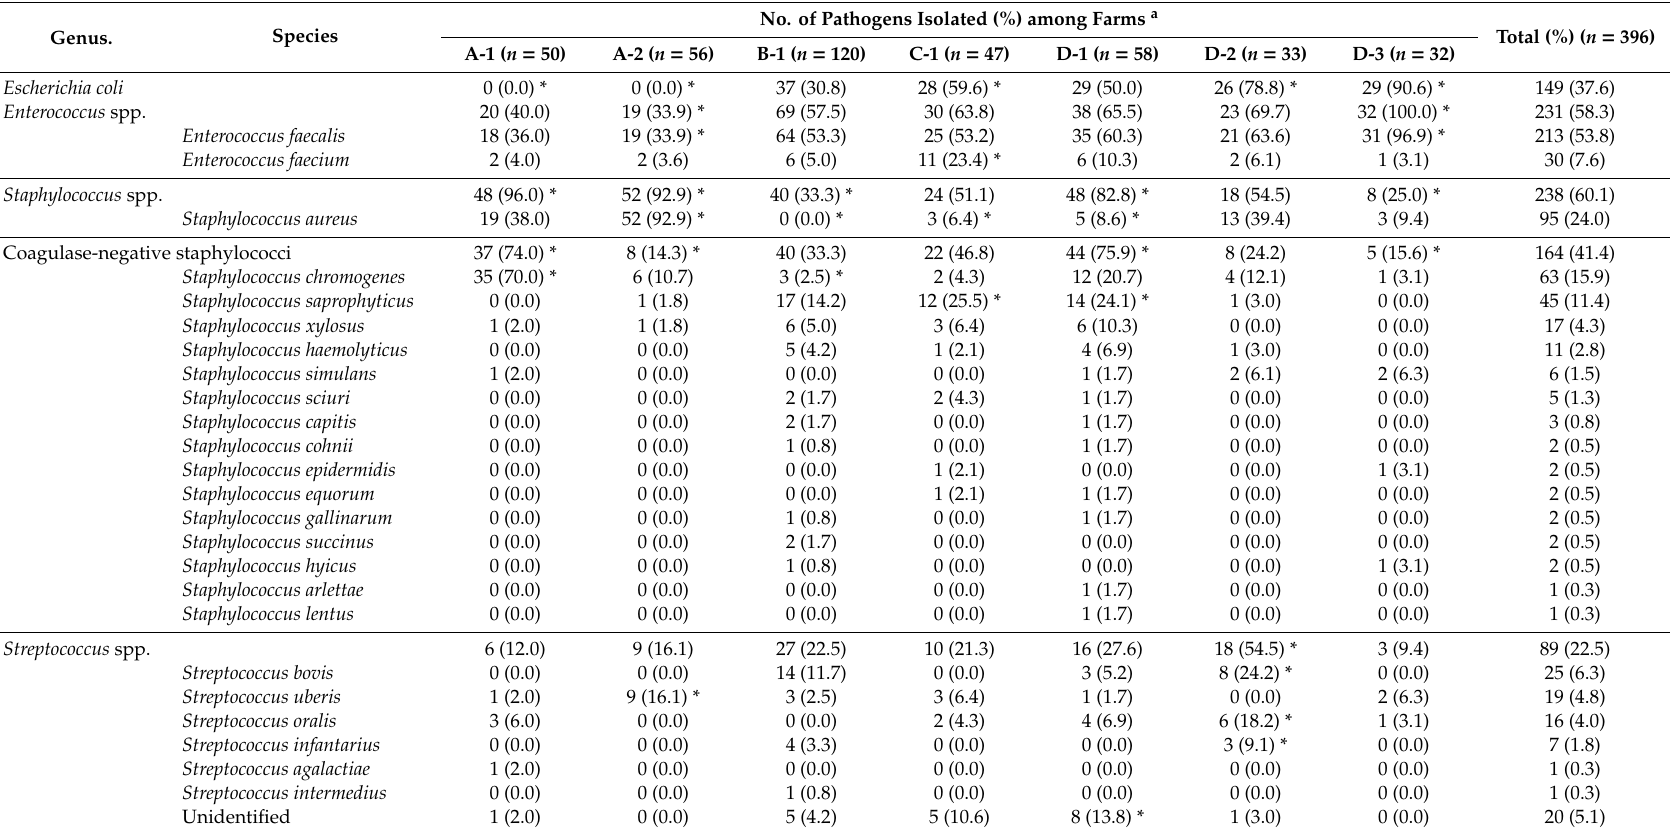
Table 3. Species and distribution of pathogens isolated from 396 dairy farms among seven dairy